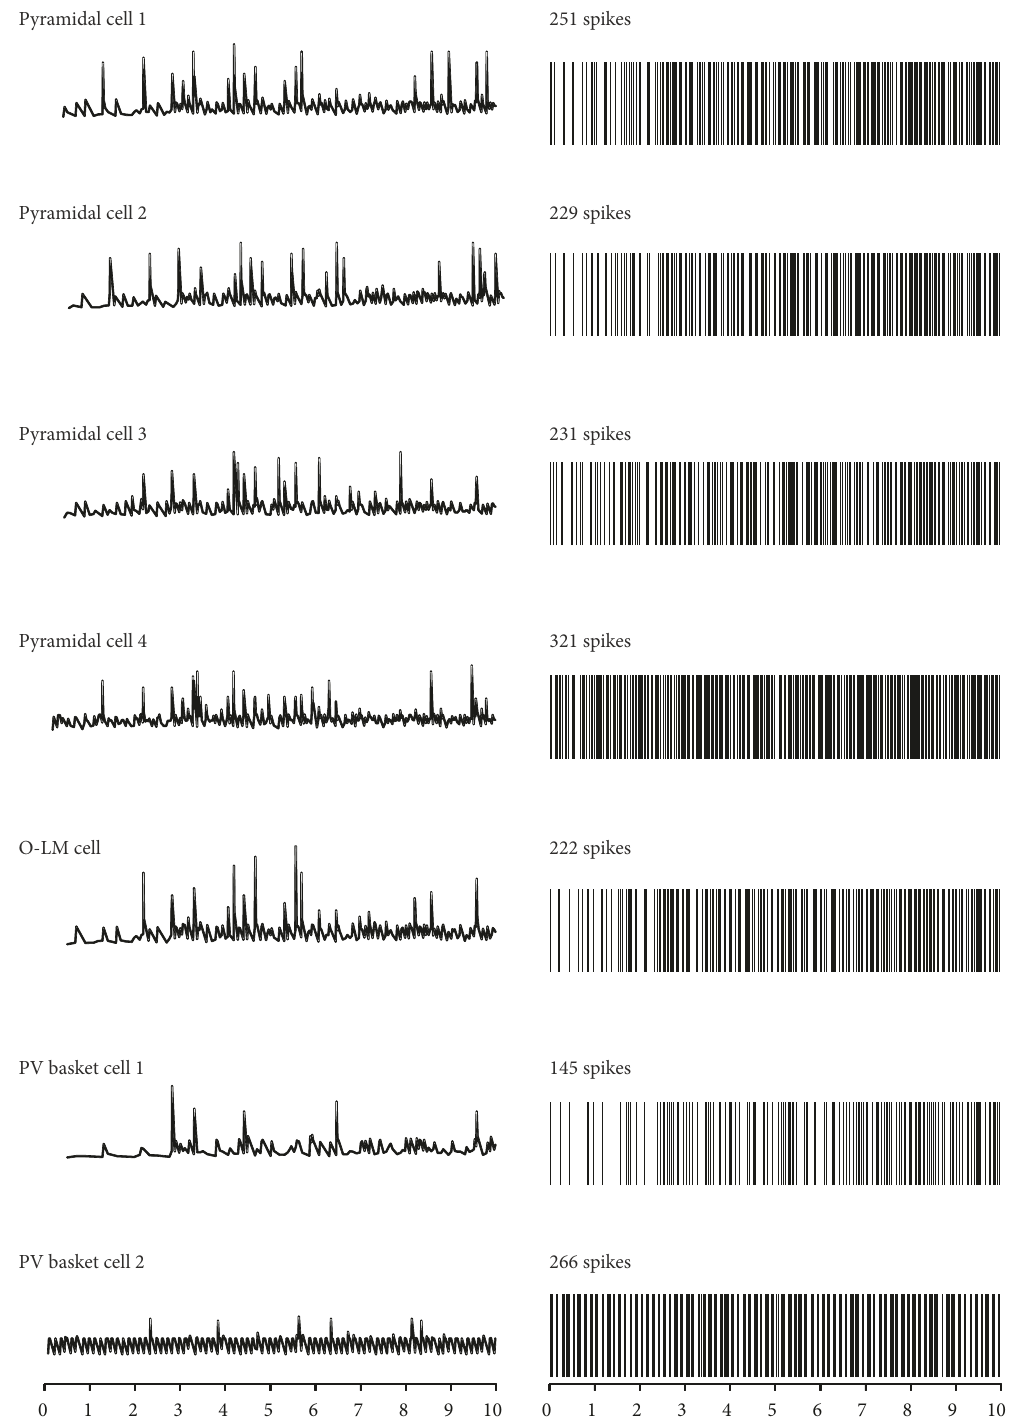
Figure 2: Basic 10-second real-time simulation of pyramidal cells, basket cells, and OL-M cell without LTP inducing protocol. On the left, time course of summarized postsynaptic potential for all cells of CA1 region. On the right, output spikes train. Time (s), forecast time of duration LTP at the end of